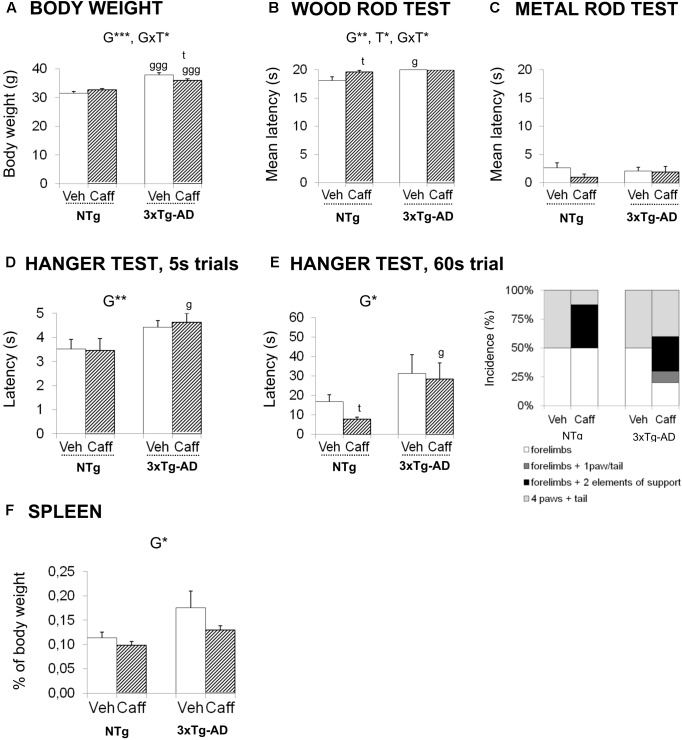
Effects of chronic caffeine treatment on body weight, sensorimotor functions, percentage of weight of spleen, and plasmatic corticosterone levels in NTg and 3xTg-AD mice at 13 months of age. (A) Body weight and (B–G) behavioral variables (as indicated) on the wood rod test (B), metal rod test (C) and the two hanger tests (D,E). The relative weight of spleen (F) and corticosterone levels (G). Data are expressed by mean ± SEM or percentage (%). Veh, vehicle; Caff, caffeine. The text at the top of each graph refers to the p-values of the 2 × 2 ANOVA: G, genotype effect; T, treatment effect; GxT, genotype × treatment interaction; ∗p < 0.05, ∗∗p < 0.01, ∗∗∗p < 0.001. Post hoc comparisons are shown in the graphs as: g p < 0.05, gg p < 0.01 vs. the corresponding NTg group; ∗p < 0.05, ∗∗p < 0.01, ∗∗∗p < 0.001 vs. the corresponding non-treated group.